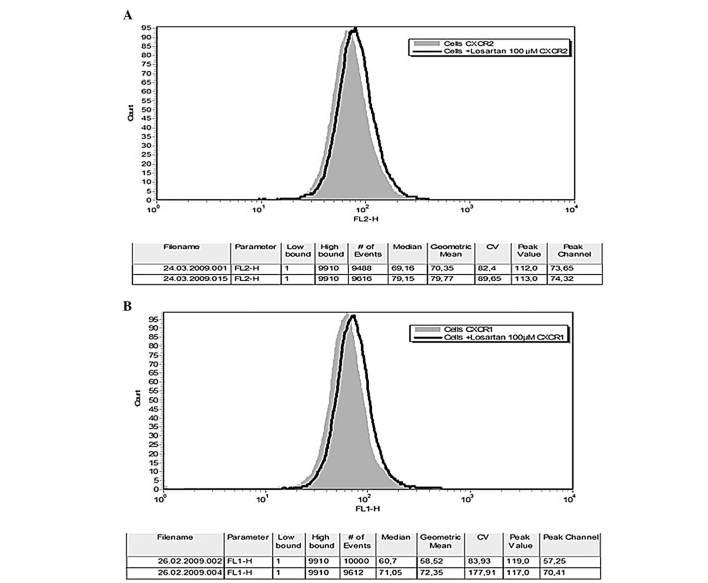
Representative histogram plots of (A) CXCR2 and (B) CXCR1 fluorescence intensity of THP-1 monocytes in the naïve state (grey area) and THP-1 monocytes treated with losartan (bold line).